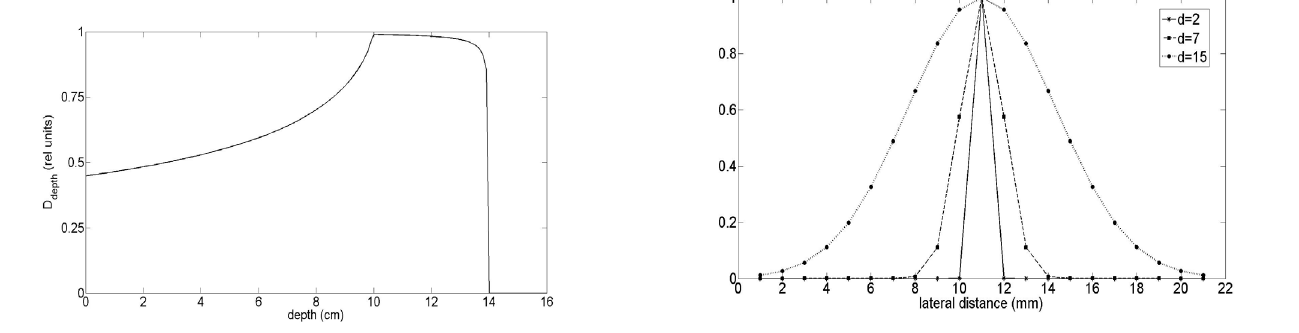
Fig. 4. Superposition of weighted Bragg peaks creating a SOBP.